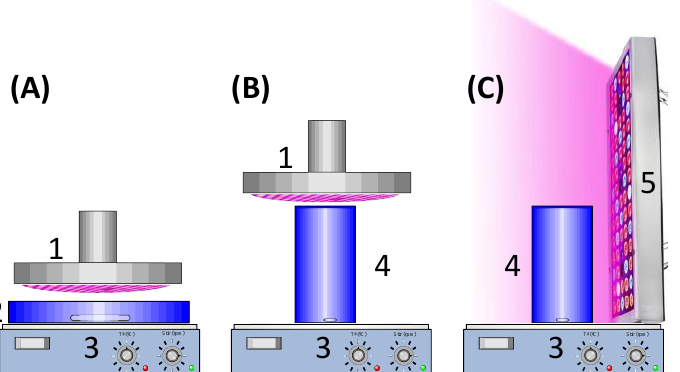
Figure 1. Proposed reactors: ( A ) wide-open-UVA reactor, ( B ) narrow-open-UVA reactor, ( C ) visible reactor, where 1: UVA LED lamp, 2: 10 cm ø, 1.5 cm high cylindrical reactor, 3: magnetic stirring, 4: 6 cm ø, 10 cm high cylindrical reactor, 5: visible lamp.